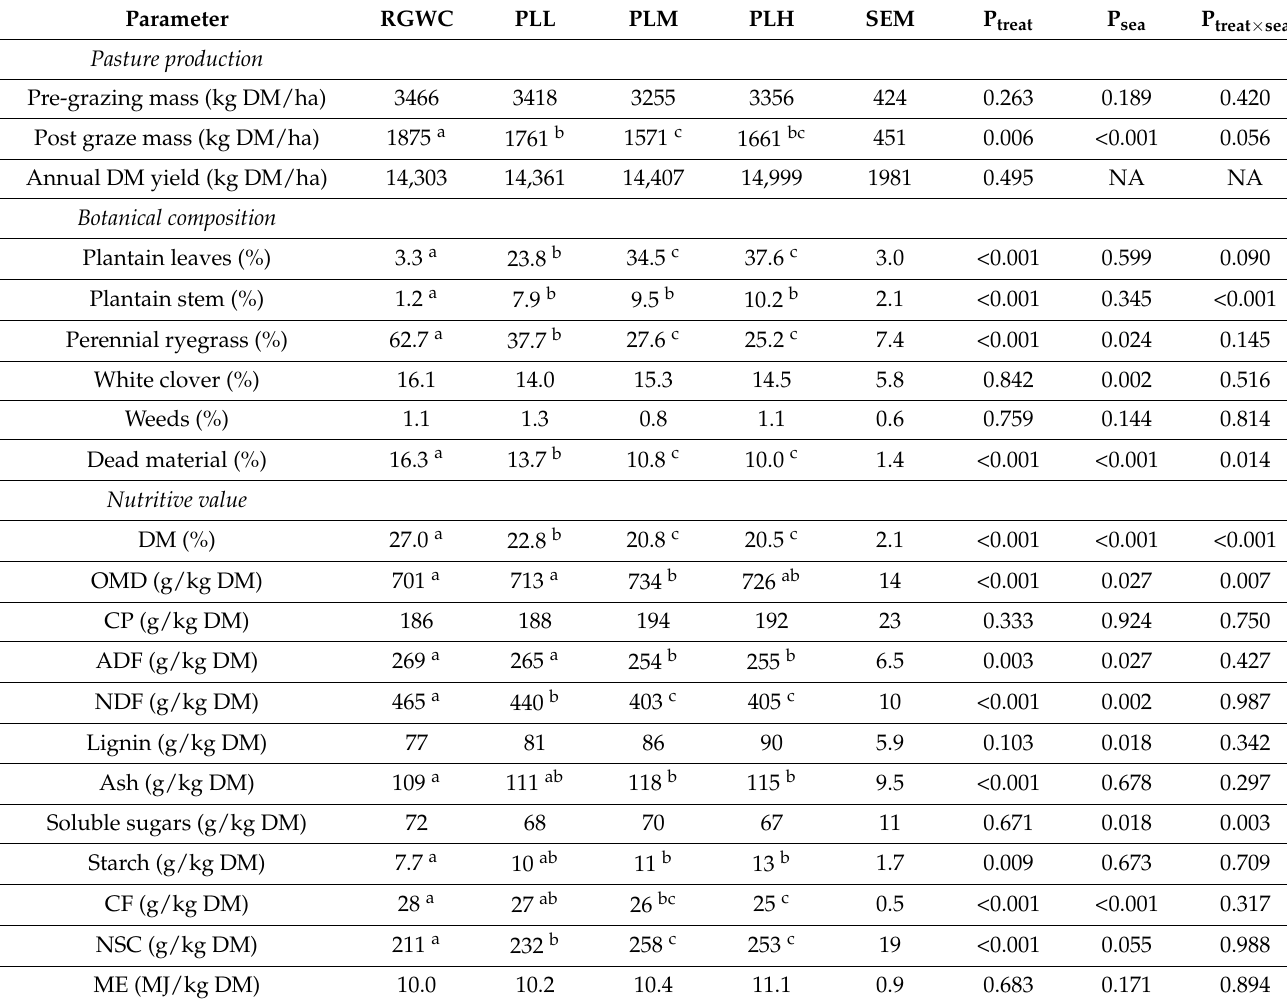
Table 3. Mean, standard error of the mean (SEM), and p -values for parameters of pasture production, botanical composition, nutritive value, the content of minerals and bioactive compounds in RGWC, PLL, PLM,